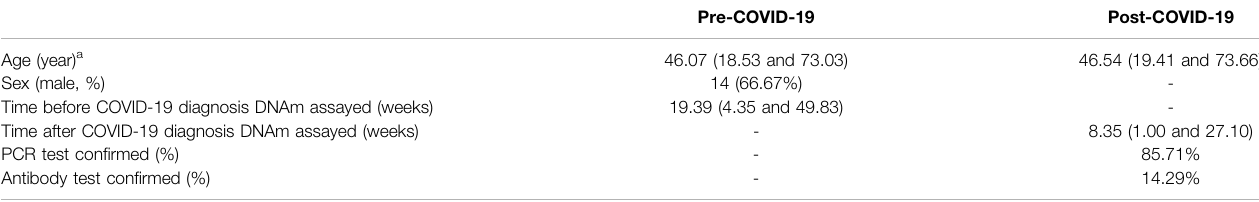
TABLE 1 | Baseline characteristics of study participants prior to COVID-19 diagnosis.